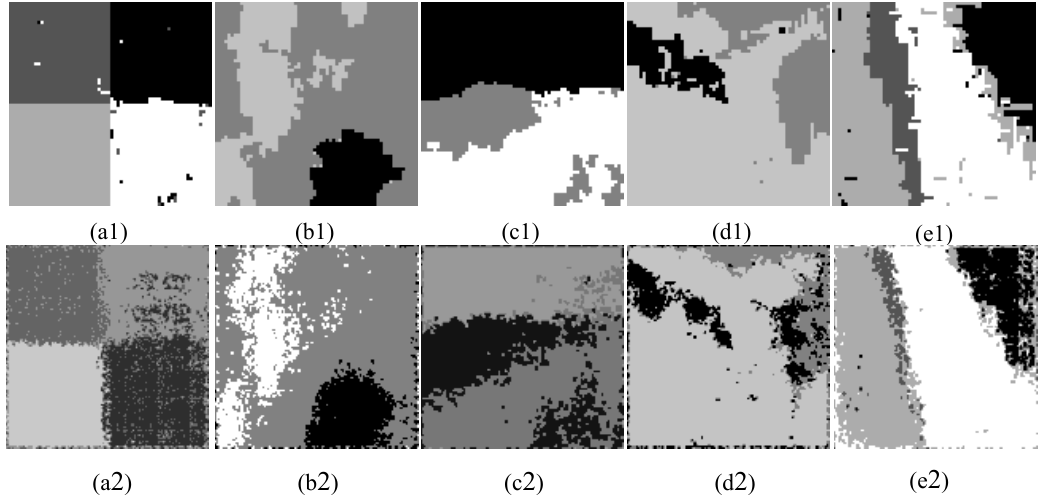
Figure 11. Segmentation results of comparison methods: ( a1 )–( e1 ) The proposed method without weight, ( a2 )–( e2 ) FCN-based method.